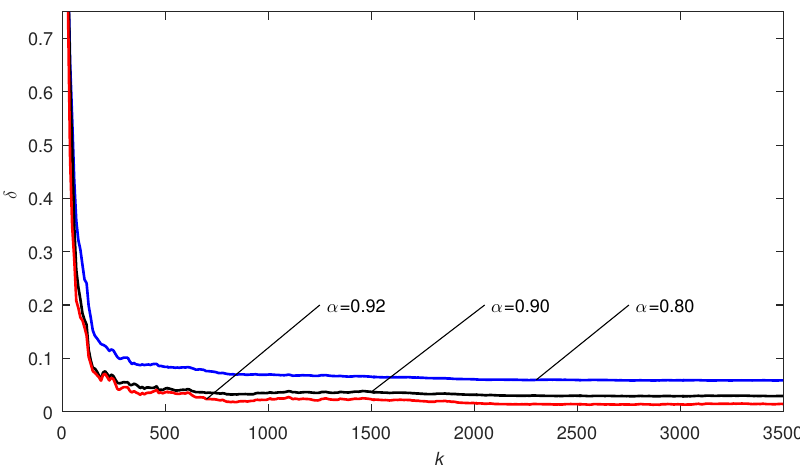
Figure 5. The AM-MIFSG estimation error δ versus k with α = 0.80, 0.90 and 0.92 ( p = 6).